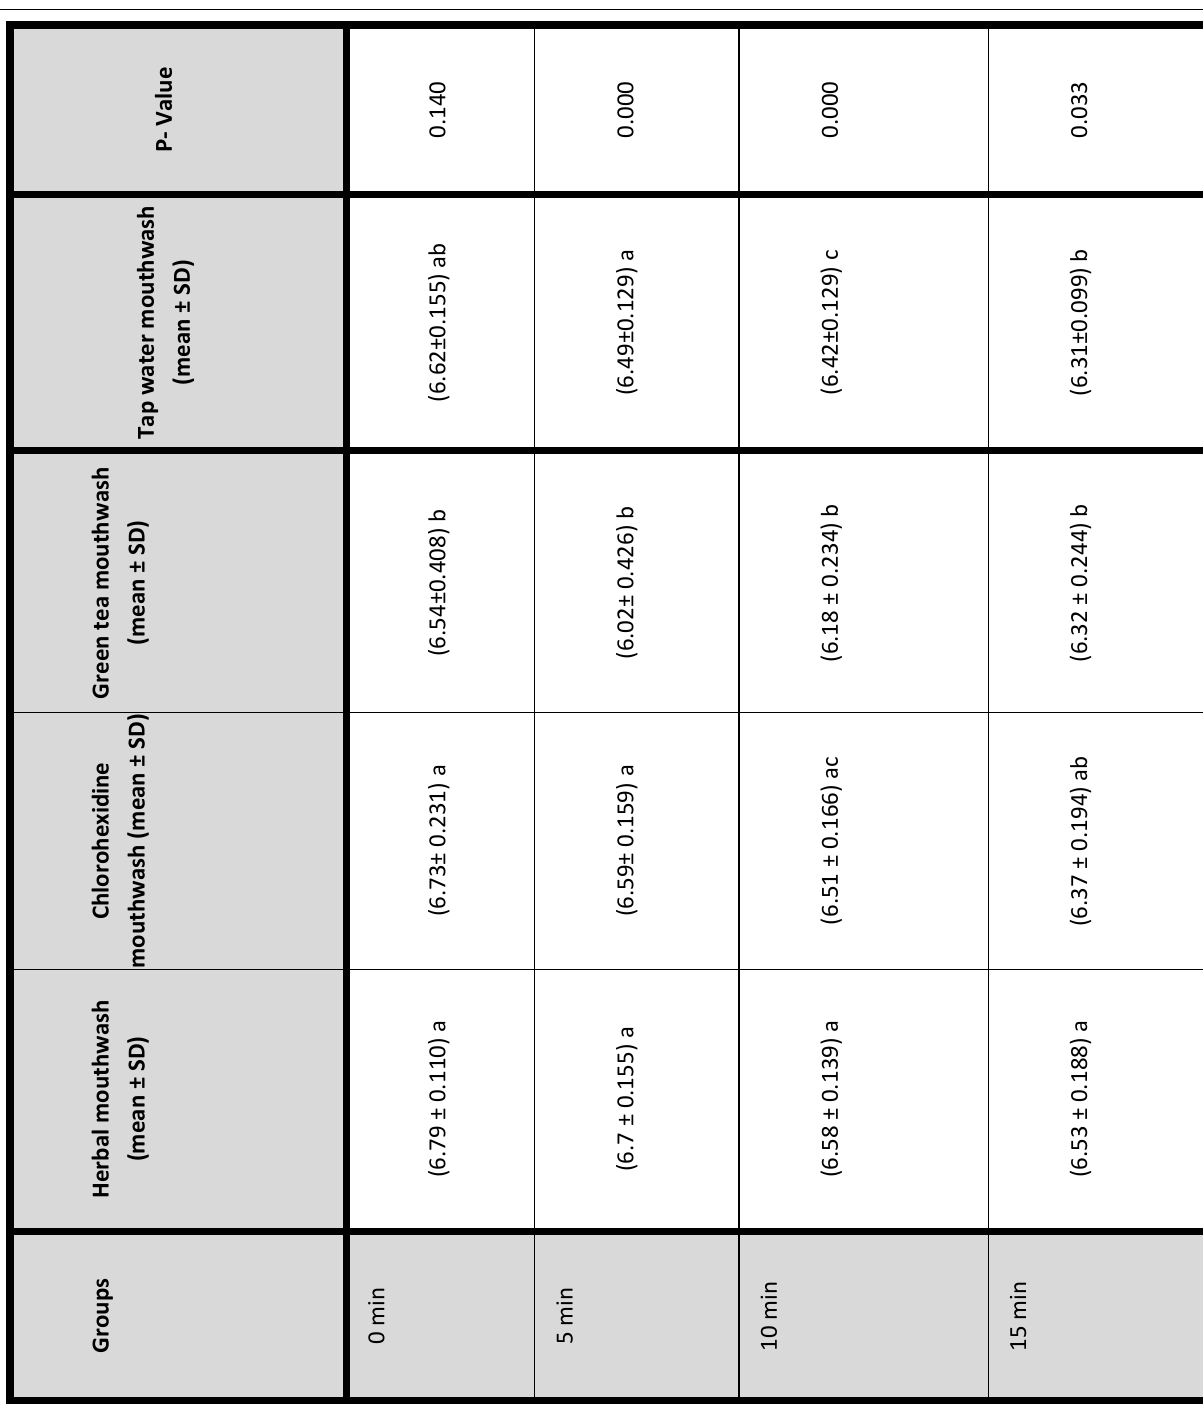
Table 6. One way ANOVA of salivary pH after green tea mouthwash